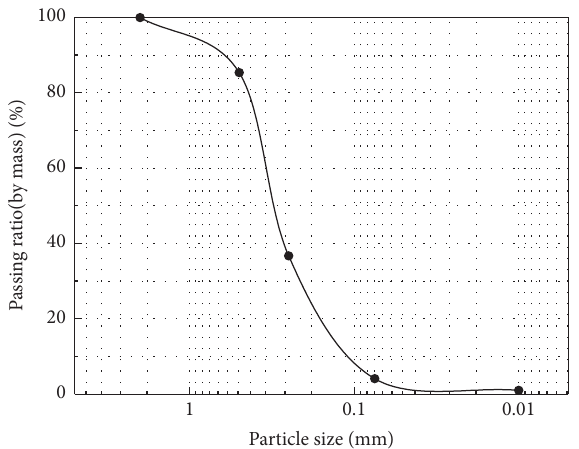
Figure 2: Particle size distribution of calcareous sand. Table 1: Overview of sand characteristics [28, 29].